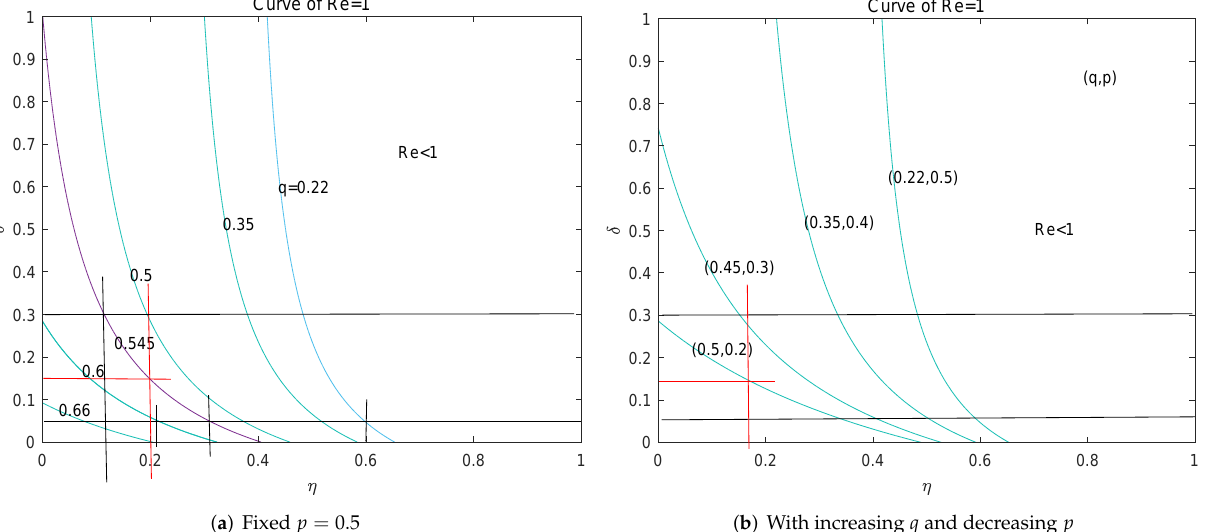
Figure 6: Investigations on curves of R